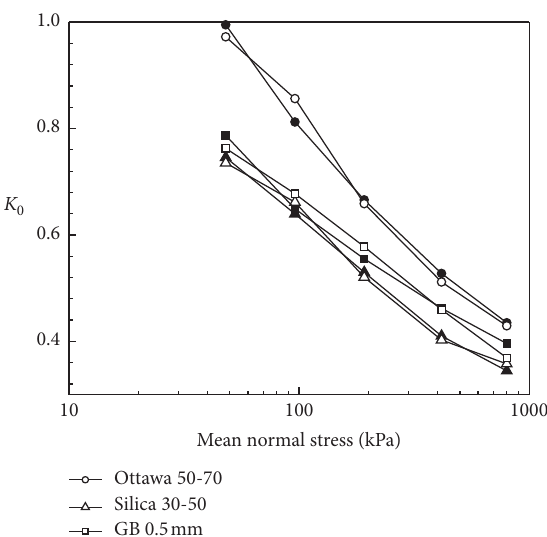
Figure 9: Comparison between the fitted K 0 (by equation (9)) and tested K 0 (solid symbols are the estimated K 0 and hollow symbols are the direct measured K 0